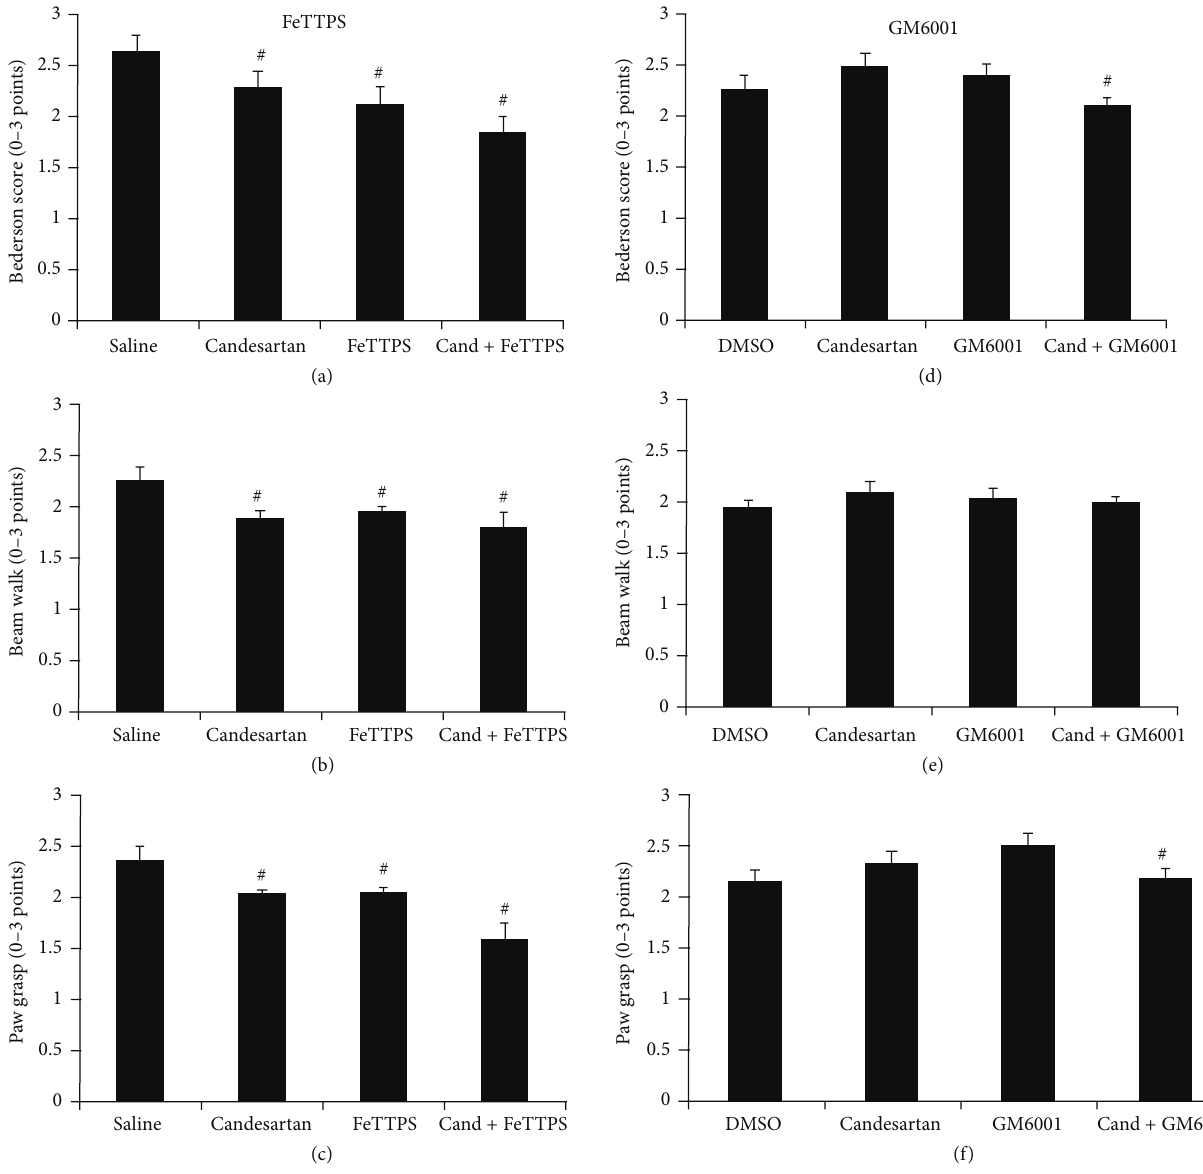
Figure 4: Effects of candesartan alone and in combination with FeTPPS and GM6001 on neurobehavioral tests: Bederson scores (a, d), beam walk (c, e), and paw grasp (c, f) at 24h after MCAO. All three treatment groups in FeTTPS demonstrated improved behavior compared to the saline treated group ( # 𝑃 < 0.05 ). Candesartan did not affect neurobehavioral outcomes when administered with DMSO, but the combination of candesartan with GM6001 resulted in significantly improved outcomes in Bederson score and paw grasp. Values are mean ± SEM ( # 𝑃 < 0.05